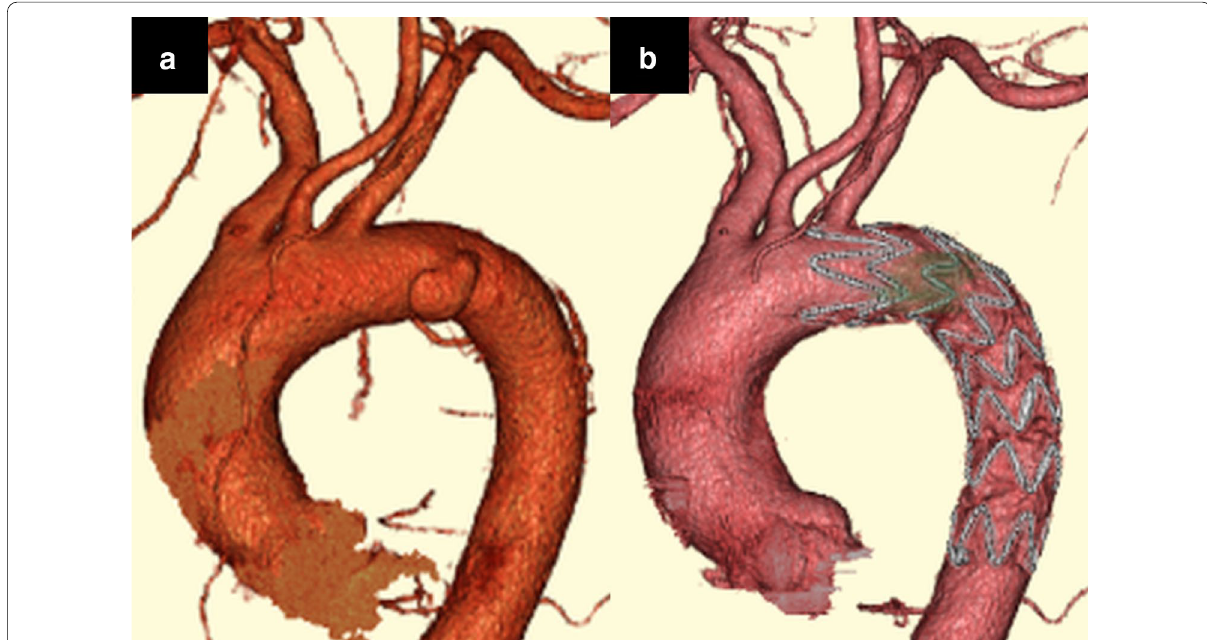
Fig. 3 Computed tomography angiogram images. a Thoracic aortic aneurysm (35 mm) approximately 15 mm from the left subclavian artery with atheromatic plaque (preoperative). b Postoperative confirmation of absence of